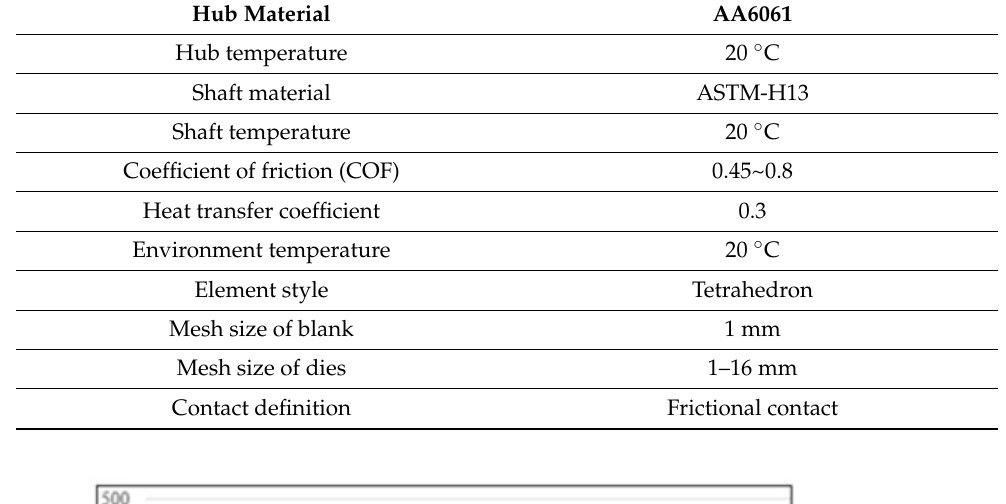
Table 3. The parameters of the forging process.